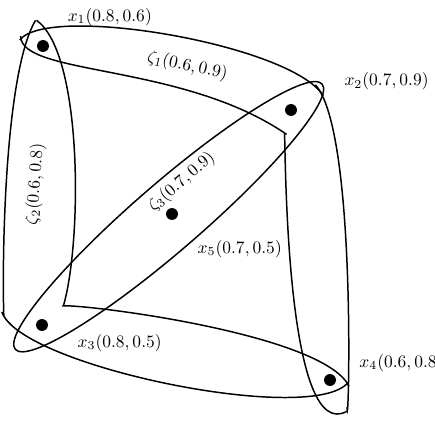
Figure 5. Five-rung orthopair fuzzy hypergraph